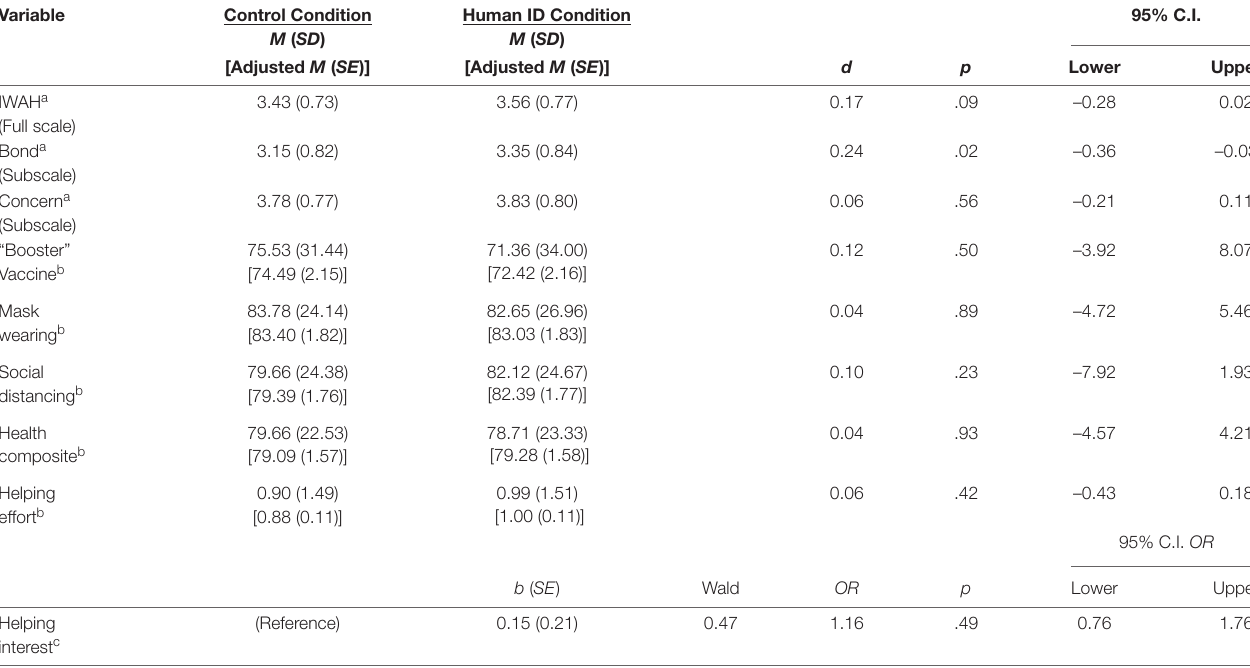
TABLE 4 | Descriptive statistics and results of t -tests, ANCOVAs, and binary logistic regression in Study 2.